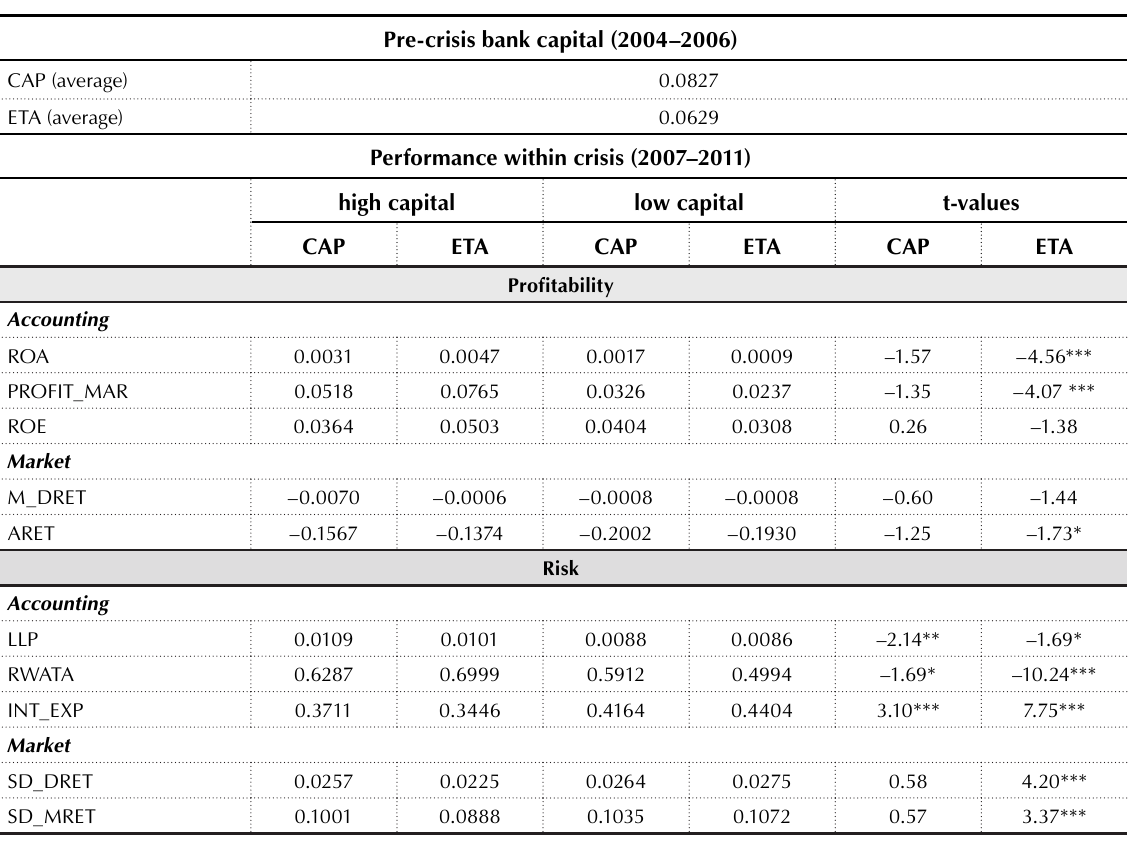
Table 8. Performance of better capitalized banks during times of